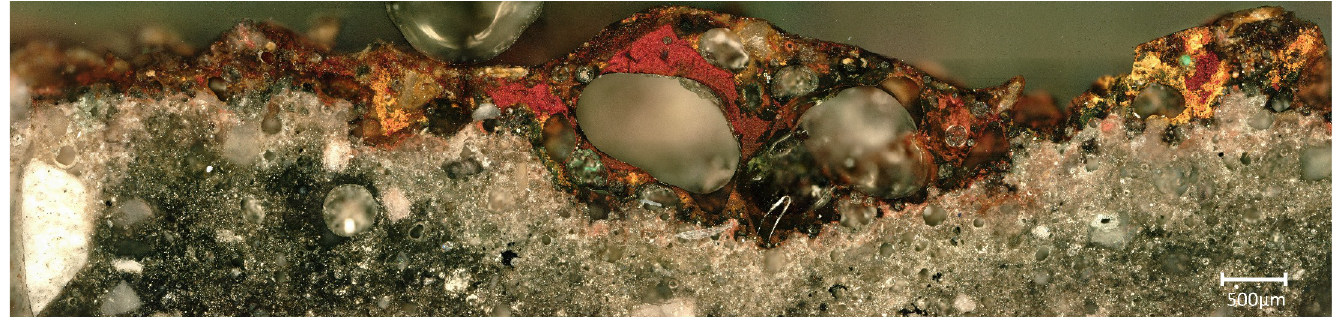
Fig 5. XPL micrograph of G11 with the thickest of all slag layers analysed. Note the interaction between the slag layer and the ceramic and the development of bloating pores. (Scale = 500 μ m).